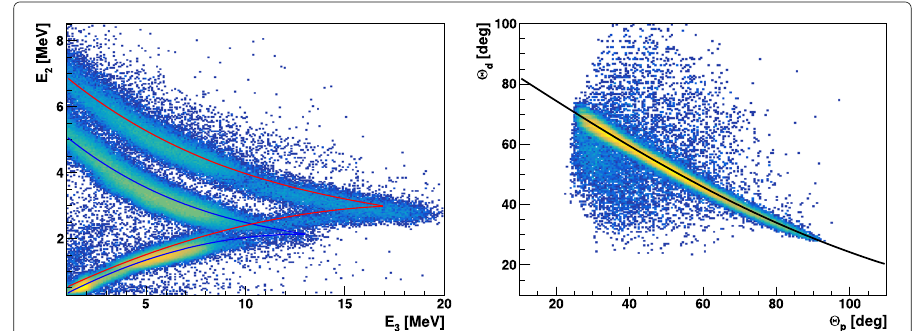
Fig. 19 Left: Energy deposit in the second layer vs. deposit in the third for the tracks with 60 ◦ < θ < 80 ◦ . The two upper bands contain deuterons and protons stopped in the third layer, with the deuteron band above. The lower rising band contains the particles passing through the third layer. The curves represent the energy deposit derived from simulations: red for deuterons, blue for protons. Right: Correlation of laboratory polar angles in two-track events, selected by pd -elastic azimuthal correlation. The energy loss cuts are applied to select protons and deuterons passing through the third